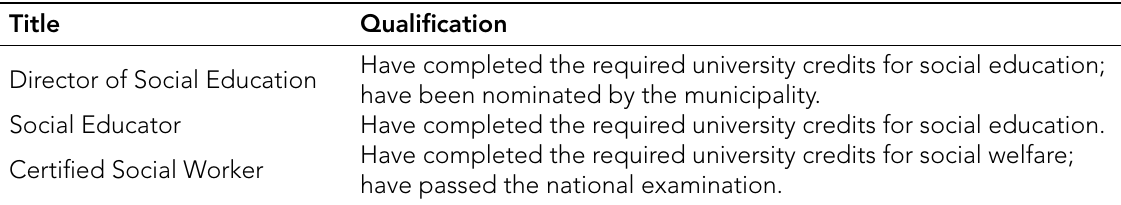
Table 2. The qualifications of